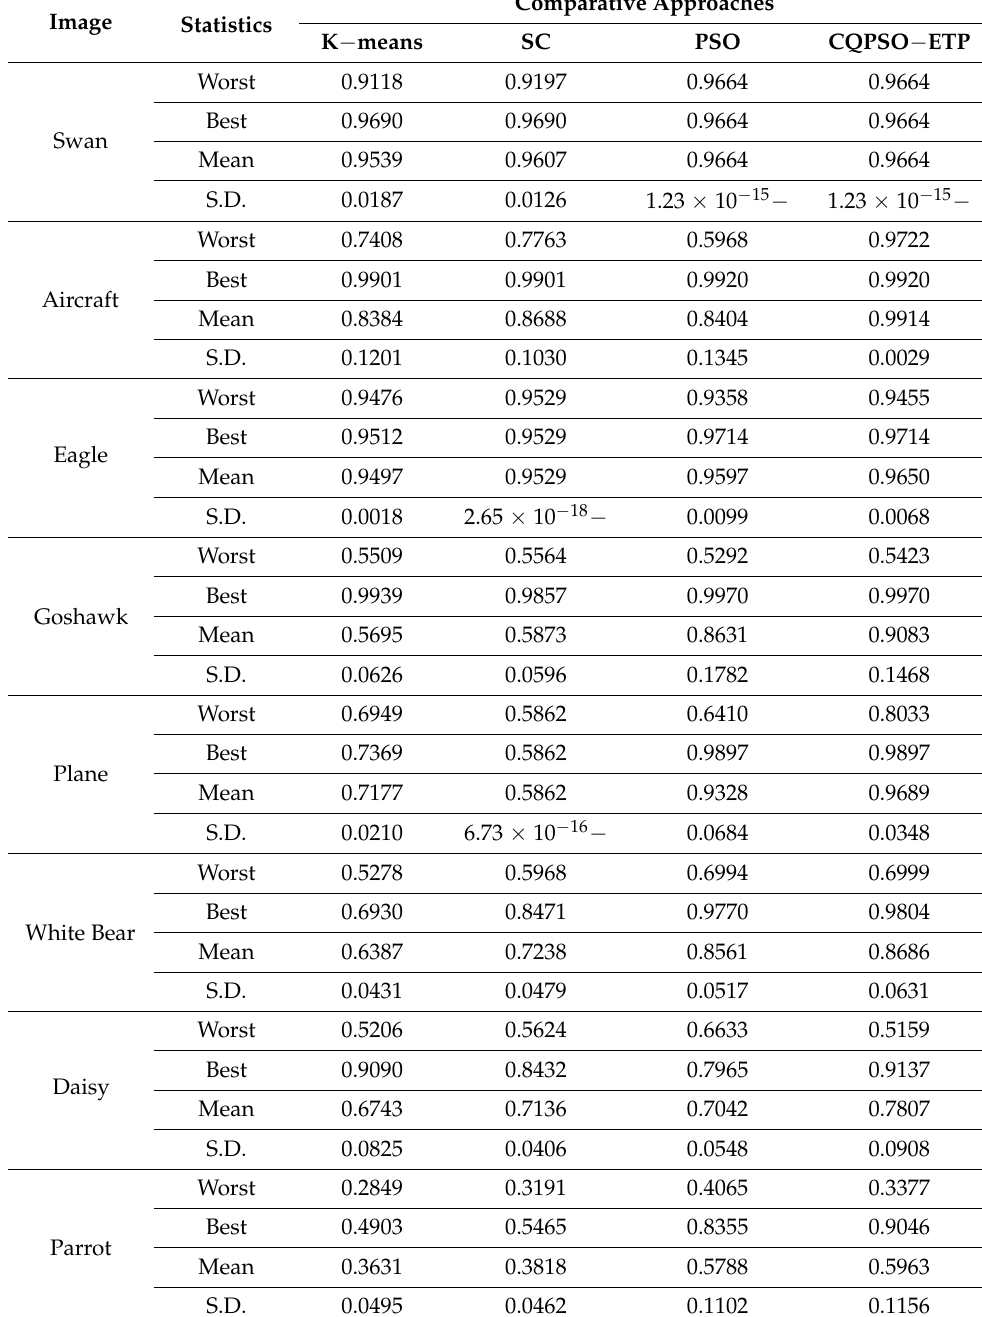
Table 8. Clustering accuracy of the comparative clustering approaches on eight tested